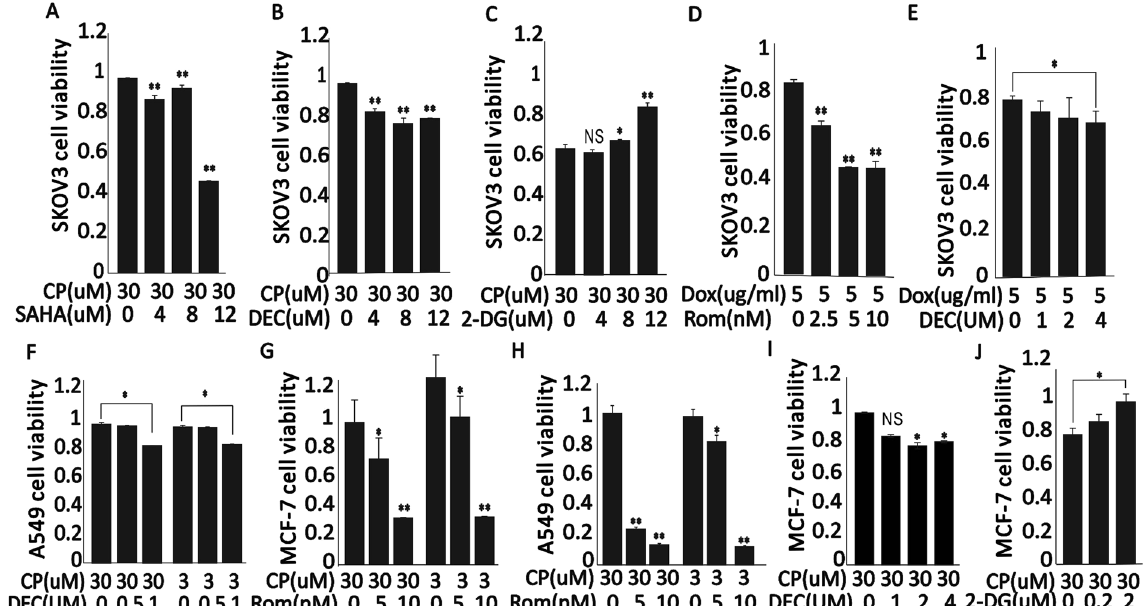
Figure 2. ETD Increases the sensitivity to DTD induced apoptosis. ( A , B and C ), Skov3 cell viability when cells were exposed to 30 uM CP combined with 0 uM, 4 uM, 8 uM or 12 uM SAHA for 24 h, 0 uM, 1 uM, 2 uM or 4 uM DEC for 24 h, or 0 uM, 0.2 uM, 2 uM or 20 uM 2-DG for 36 h. ( D and E ) Skov3 cell viability when cells were exposed to 5 ug/ml DOX combined with 0 nM, 2.5 nM, 5 nM or 10 nM Rom for 24 h or 0 uM, 1 uM, 2 uM or 4 uM DEC for 24 h. ( F ) A549 cell viability when cells were exposed to 30 uM or 3 uM CP combined with 0 uM, 0.5 uM, 1 uM DEC for 24 h. ( G ) MCF7 cell viability when cells were exposed to 30 uM or 3 uM CP combined with 0 nM, 5 nM or 10 nM Rom for 24 h. ( H ) A549 cell viability when cells were exposed to 30 uM or 3 uM CP combined with 0 nM, 5 nM or 10 nM Rom for 24 h. ( I and J ), MCF7 cell viability when cells were exposed to 30 uM CP combined with 0 uM, 1 uM, 2 uM or 4 uM DEC for 24 h or 0 mM, 0.2 mM, 2 mM or 20 mM 2-DG for 36 h. ( * means P < 0.05, ** means P < 0.001, n ≥